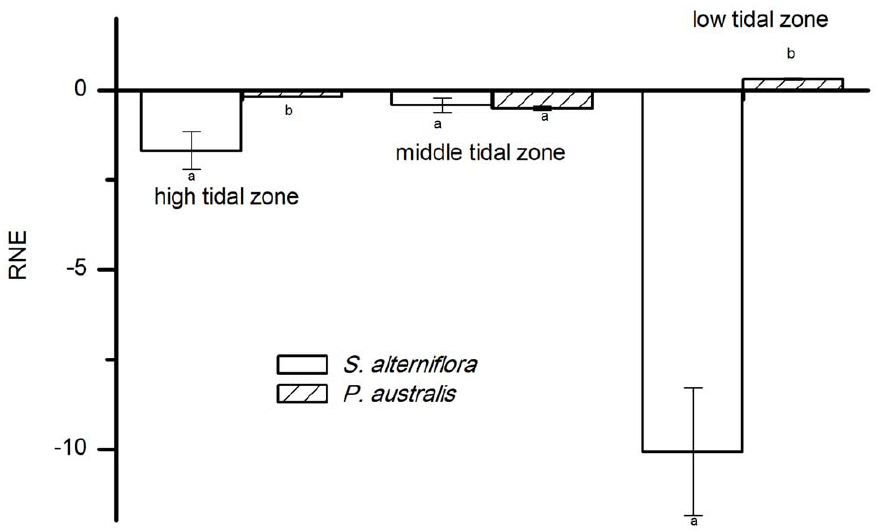
Figure 4. The relative neighbor effect (RNE) of P.australis and S.alterniflora in different tidal zones. The performance of target plants was measured by the number of newly produced tillers per day (TNT). Different letters indicate significant differences.